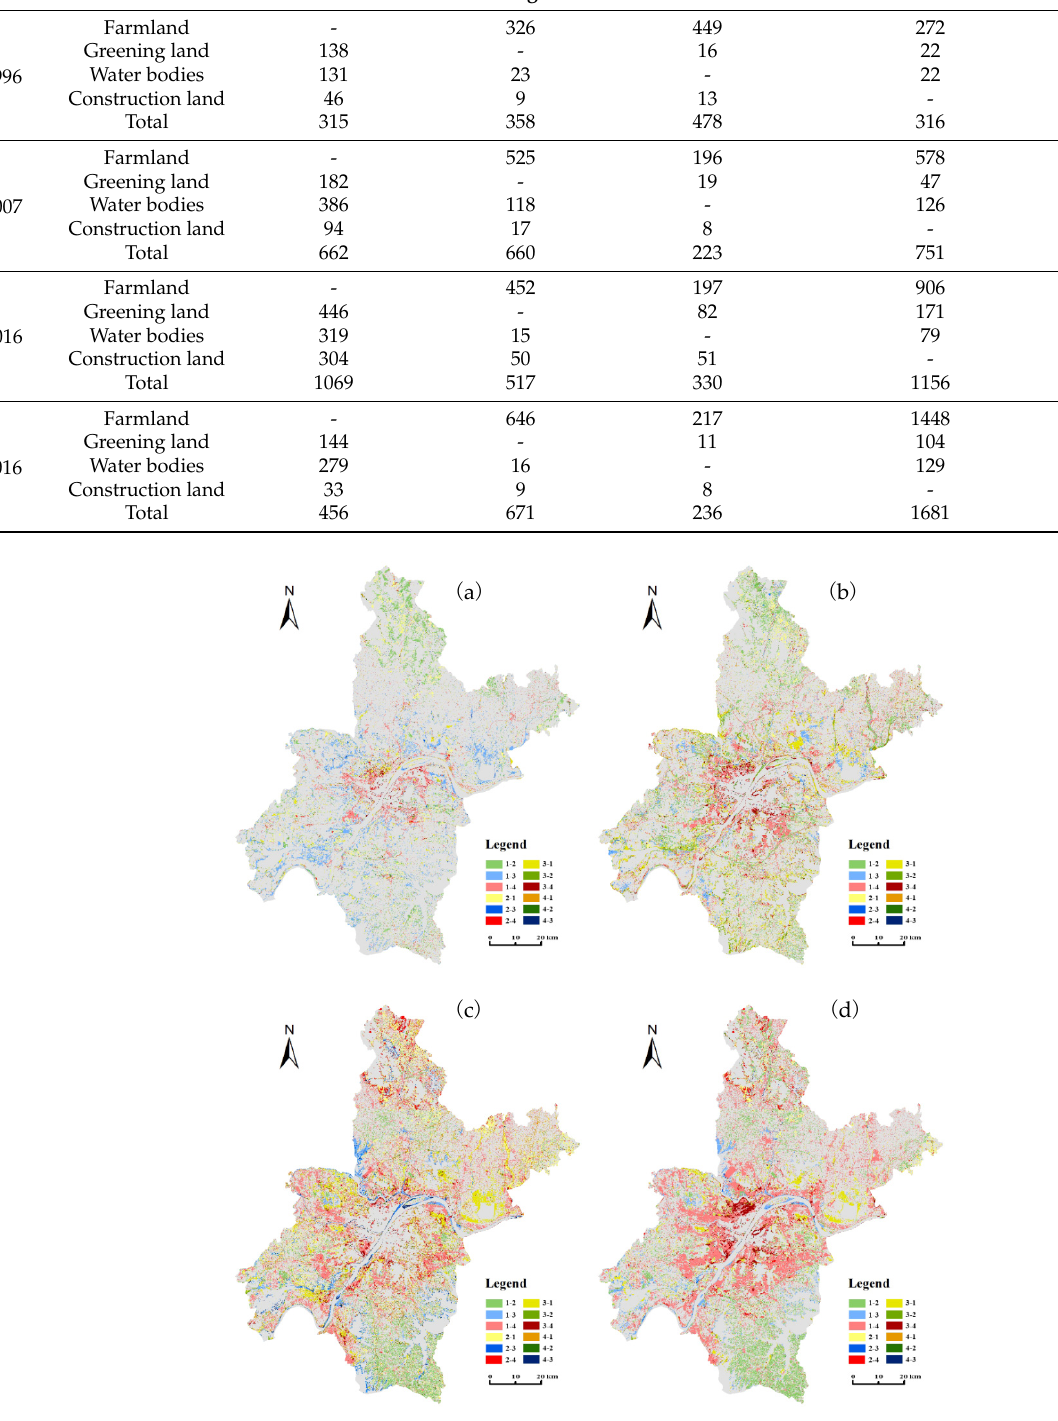
Figure 3. Spatiotemporal transitions among different LULC types during ( a ) 1987–1996, ( b ) 1996–2007, ( c ) 2007–2016 and ( d ) 1987–2016. Note: 1, 2, 3 and 4 represents farmland, greening land, water bodies and construction land, respectively, and “-” represents the transformation process among LULC